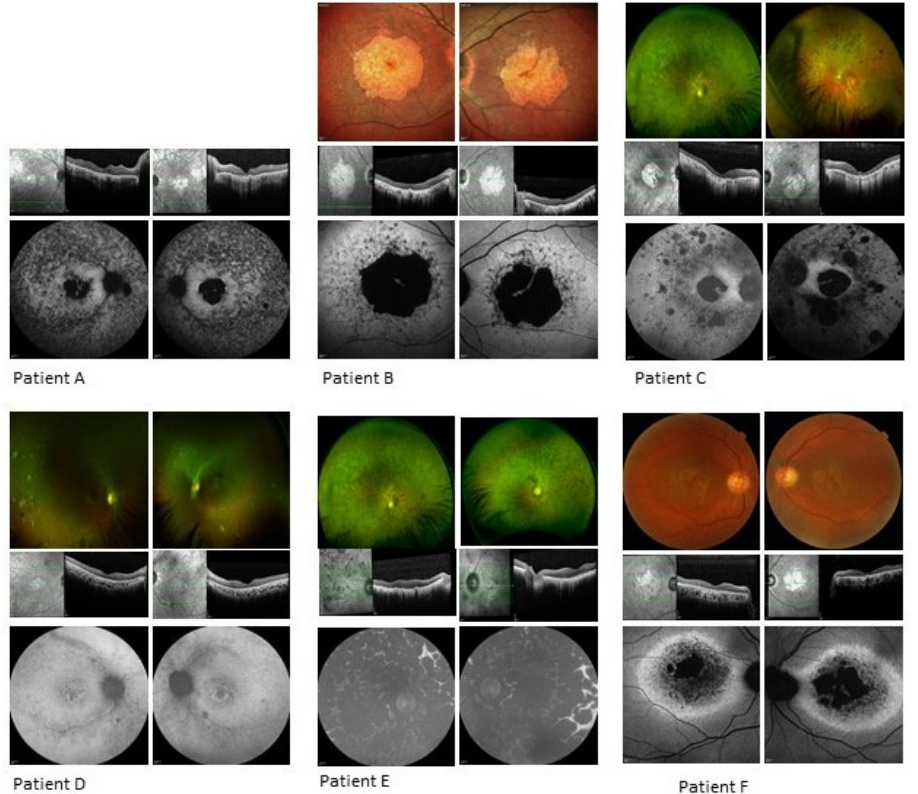
Figure 3. Retinal imaging of patients A to F. Each panel shows colour imaging, spectral domain–optical coherence tomography (SD–OCT) and fundus autofluorescence (FAF), showing the range of phenotypes. See Tables 2 and 3 for further details. The thickness of the ganglion cell–inner plexiform layer (GC–IPL) layers in the areas temporal and nasal to the area of macular atrophy were also measured (see Table